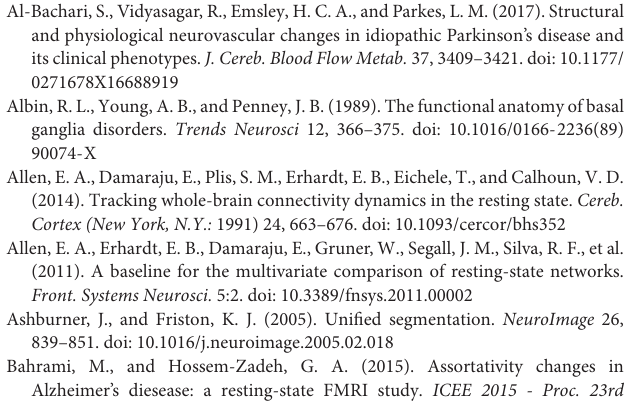
Supplementary Figure 1 | Determination of Optimal Number of Clusters for Dynamic Resting State Functional Connectivity Analysis. Using silhouette analysis, the maximal value was found to result from 2 clusters. Upon validation with Bayesian information criterion (BIC) based on the Euclidean distance between clusters, it was found that the data would be optimally grouped into either 2 or 3 clusters. As such, it was determined that each window of the dynamic resting state analysis would be classified into one of two brain